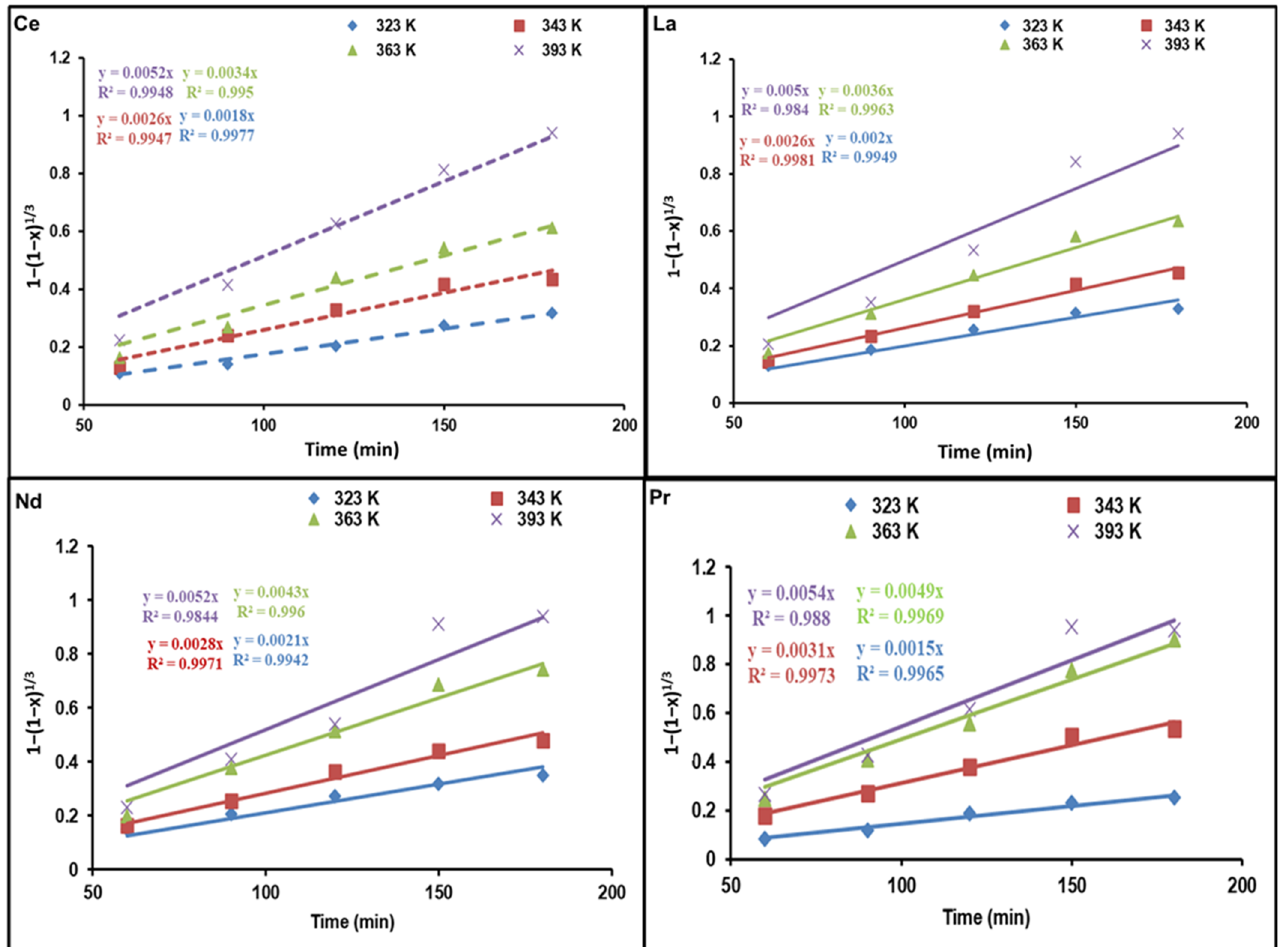
Figure 6. Influence of dissolution time on fraction of REEs dissolved, 1 − 3(1 − x ) 2/3 + 2(1 − x ), at different temperatures.